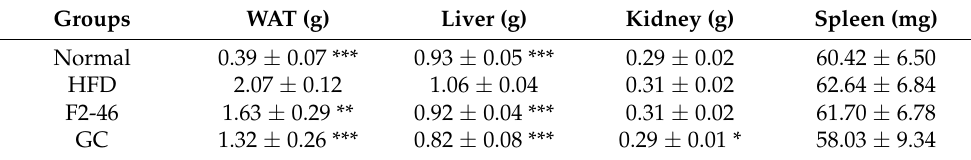
Table 6. Effect of formulation F2 on organ weights.